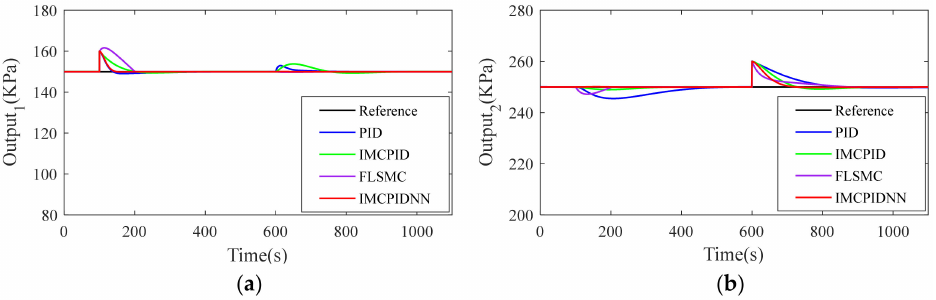
Figure 13. Comparison of closed-loop responses to external disturbance with +20% variation on time constant and gains: ( a ) Output1; ( b ) Output2.